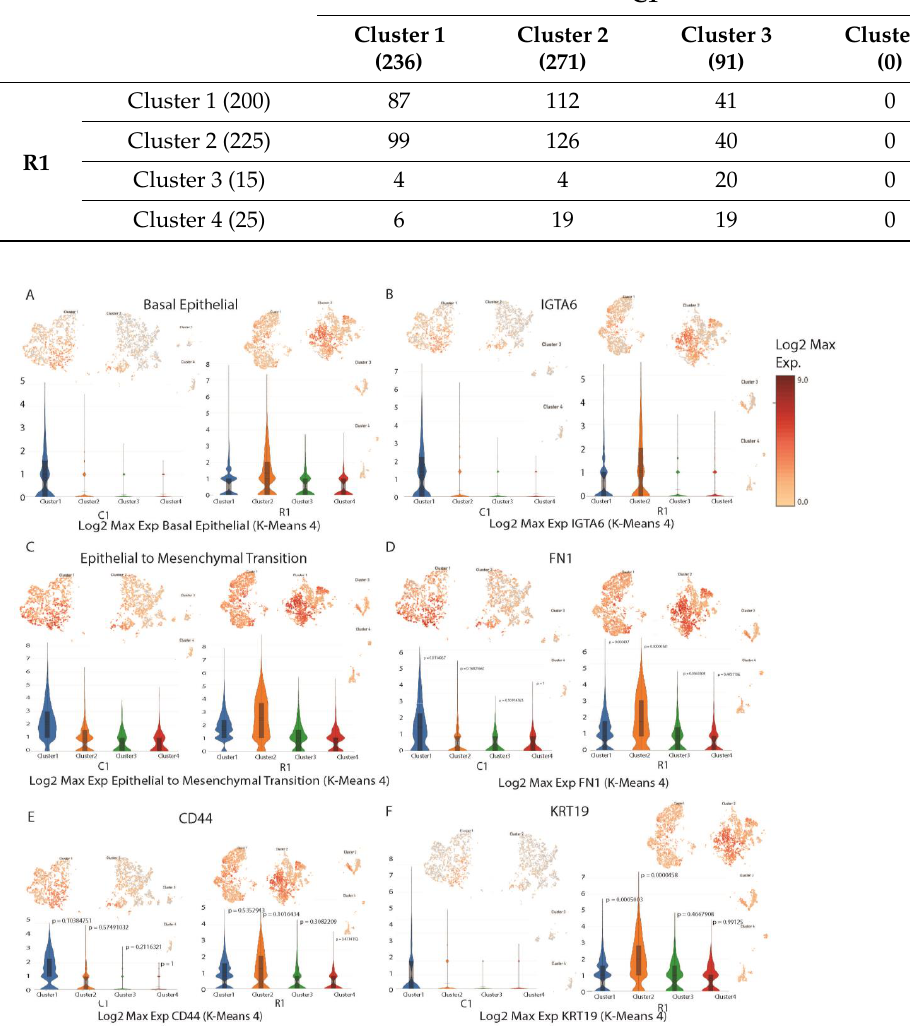
Figure 8. Cell type from single-cell analysis. ( A ) Basal epithelial cell type’s overall expression ( B ) IGTA6 gene expression (basal epithelial cell type gene) ( C ) Epithelial-to-mesenchymal transition cell type’s overall expression ( D ) FN1 gene expression (epithelial-to-mesenchymal transition cell type gene) ( E ) CD44 gene expression (epithelial-to-mesenchymal transition cell type gene). ( F ) KRT19 gene expression (luminal epithelial cell type gene). Log2 expression in 0–9.0. p -values given for significant clusters identified by the single-cell